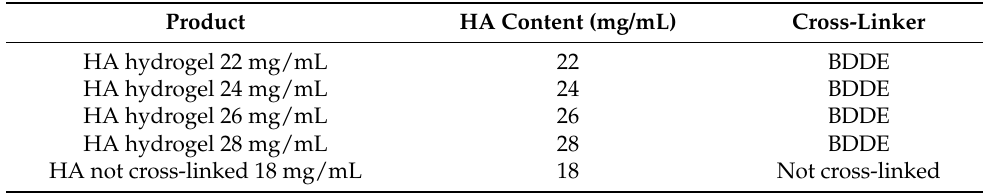
Table 1. Description of the HA-based dermal fillers provided by Matex Lab S.p.A., collected to investigate their microscopic structure and rheological